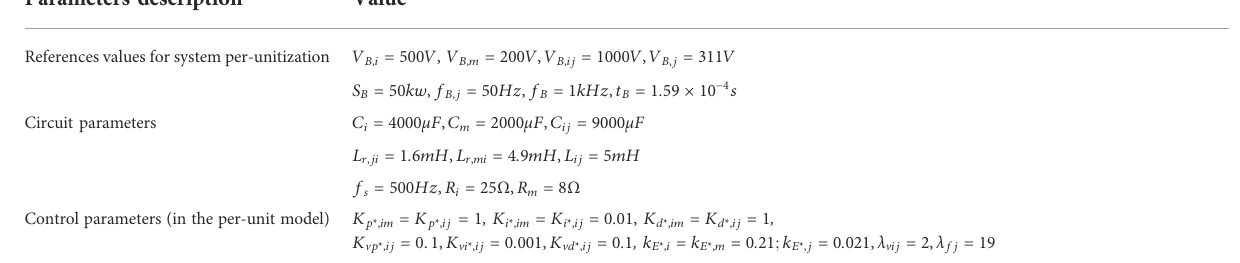
TABLE 2 Circuit parameters and control parameters of typical operating scenarios. Parameters